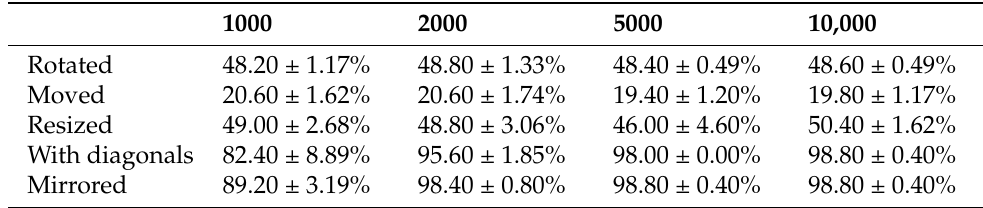
Table 9. The number of transformed objects: 0; Level of noise: 4.